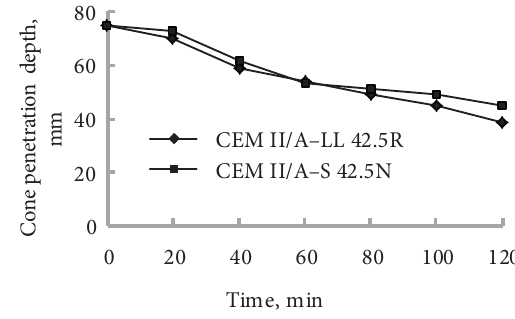
Fig. 7. A concrete mixture with different types of Portland cement and with no dependence of the depth of the cone penetration of the superplasticizer on time at a temperature of +15 °C